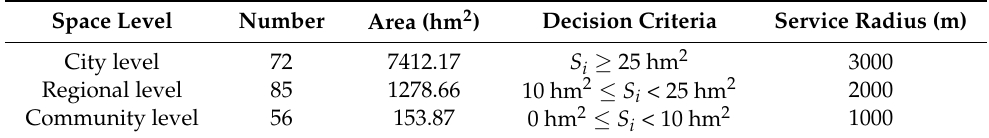
Table 1. Classification standard and basic information of urban ecological recreational